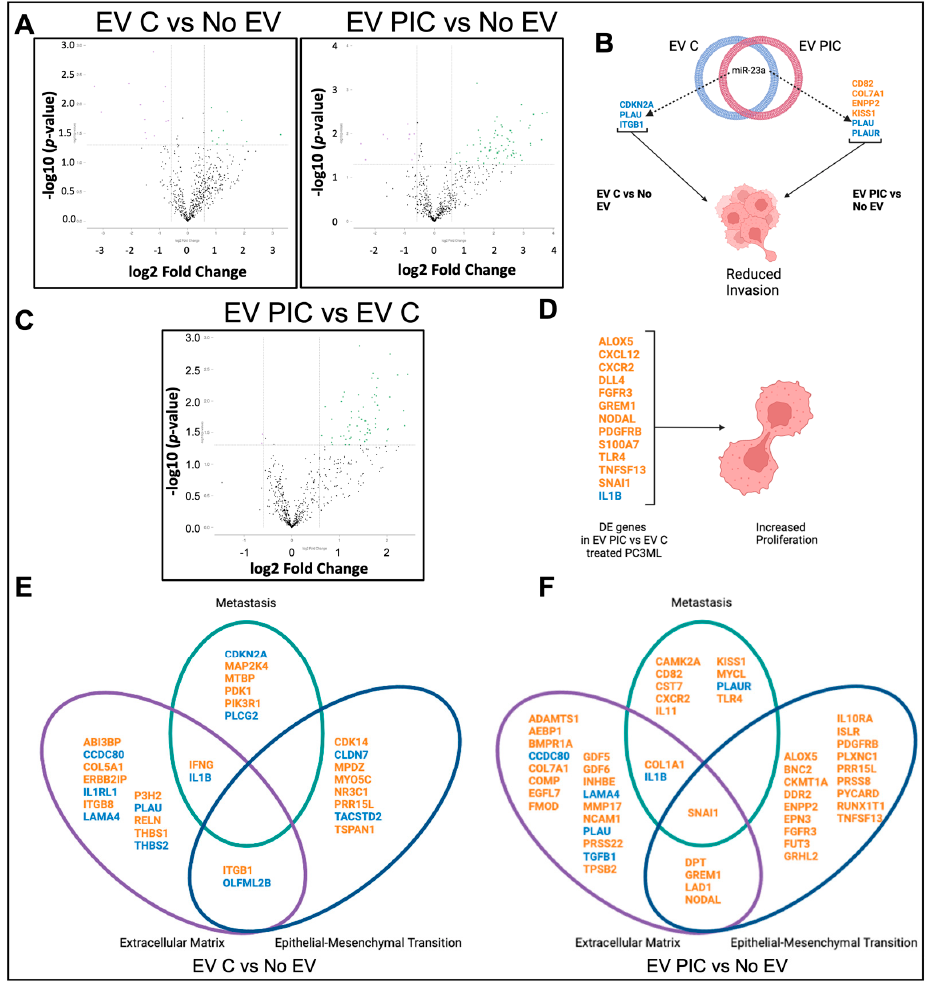
Figure 3. EV C and EV PIC deregulate genes involved in extracellular matrix remodeling, metastasis, and epithelial-mesenchymal transition. Volcano plots show DE genes with an x-axis indicating DE fold change with a threshold of +/ − 0.58 log2 fold change, p < 0.05. Differential expression (DE) analysis revealed that 38 genes were deregulated with EV C treatment and 70 with EV PIC treatment relative to untreated control ( A ). IPA was used to identify DE genes involved in invasion in both EV C- and EV PIC-treated cells, and miRNA target filter analysis identified miR-23a as targeting PLAU , which is downregulated in both EV C- and EV PIC-treated cells as compared to untreated control ( B ). DE analysis of EV PIC-treated PC3MLs vs. EV C-treated revealed 55 DE genes ( C ). IPA analysis revealed 13 DE genes whose regulation status may have an impact on observed increased proliferation ( D ). Genes deregulated by EV C or EV PIC vs. untreated PC3MLs were clustered by NanoString Pan Cancer progression panel gene annotations. Of the 38 genes deregulated in EV C vs. untreated PC3MLs, 16 clustered to extracellular matrix remodeling, 10 clustered to epithelial- mesenchymal transition, and 10 clustered to metastasis ( E ). Of the 70 genes deregulated in EV PIC vs. untreated PC3ML, 25 clustered to extracellular matrix remodeling, 23 clustered to epithelial- mesenchymal transition, and 12 to metastasis ( F ). Genes in blue are downregulated, and genes in orange are